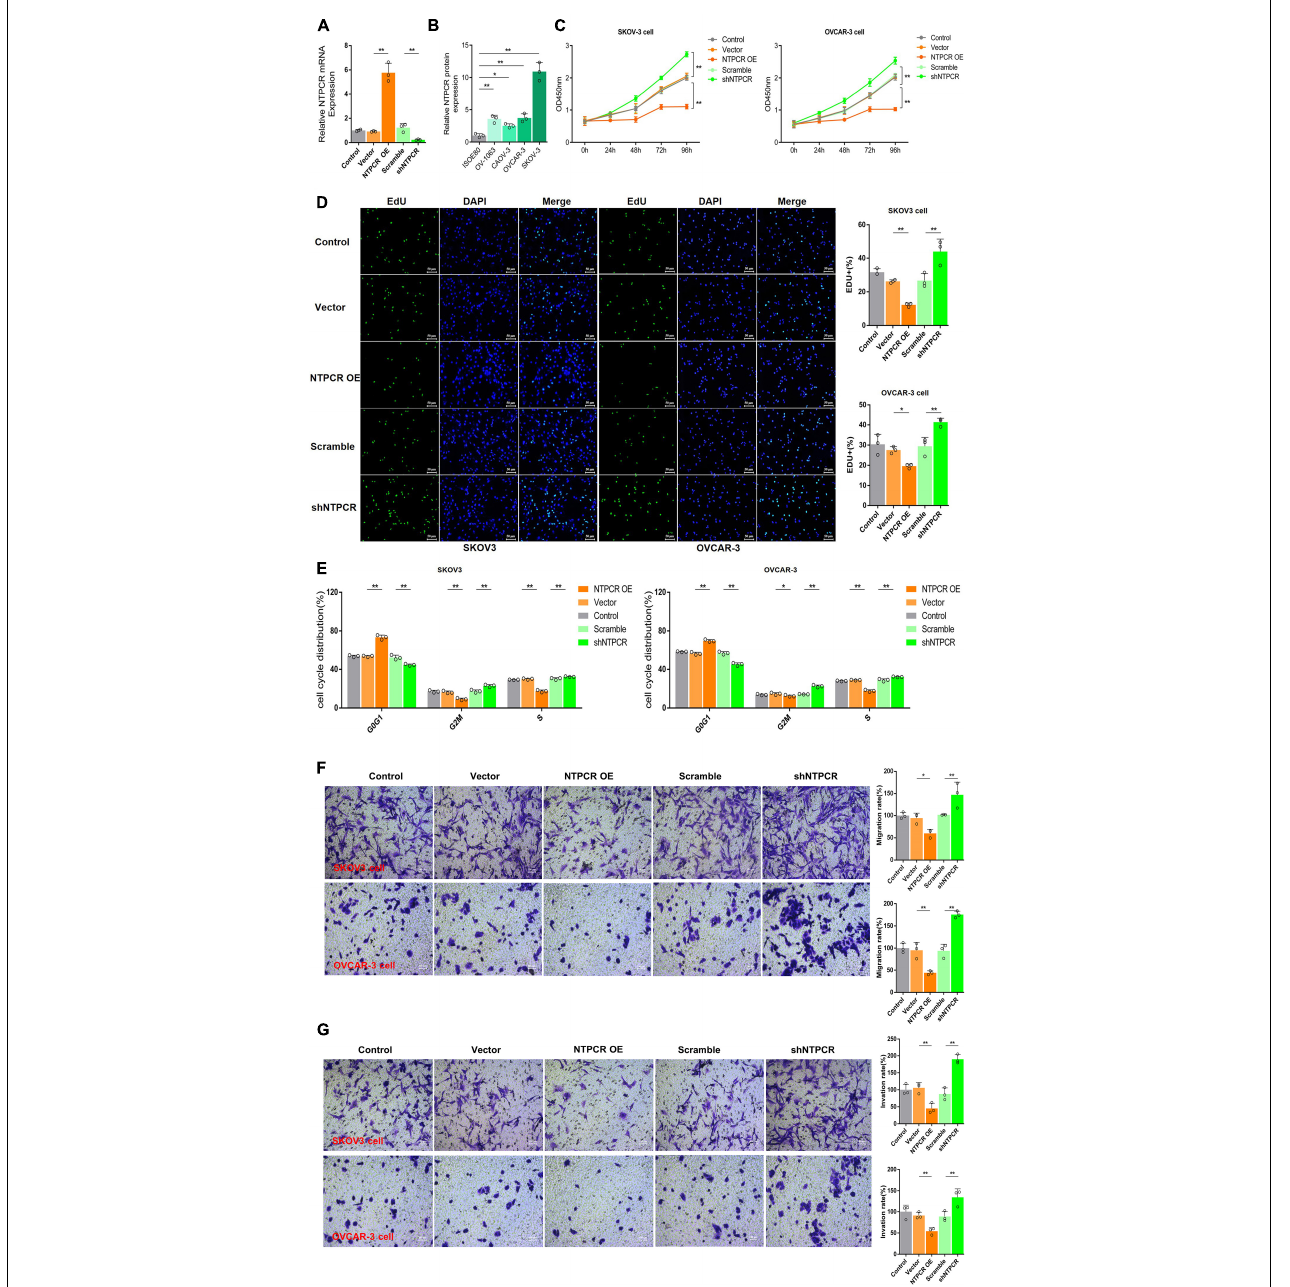
FIGURE 2 | Knocking out of NTPCR-induced cell proliferation, S phase arrest, promoted cell invasion, and migration in SKOV3 cell line. (A) The construction of the overexpression vector and interference shRNA vector of NTPCR. It can be seen from the left figure that compared with Scramble groups, the expression of NTPCR in shRNA groups was significantly reduced, and shRNA1 was more obvious. That is why we previously chose shRNA1 for the subsequent experimental studies. It also can be seen from the right figure that compared with the vector groups, the expression of NTPCR in NTPCR OE groups was significantly increased, and compared to the Scramble groups, shNTPCR groups were significantly reduced (* p < 0.05, ** p < 0.01). (B) NTPCR expression levels were significantly upregulated in four ovarian cancer cell lines (SKOV3 vs. IOSE80, p < 0.01; CAOV-3 vs. IOSE80, p < 0.05; OV-1063 vs. IOSE80, p < 0.01; and OVCAR-3 vs. IOSE80, p < 0.01) compared with the human ovarian epithelium cell line IOSE80. (C) The effect of NTPCR on the viability of epithelial ovarian cancer cells. The CCK-8 assays were performed to evaluate the cell proliferation after being cultured at 24, 48, 72, and 96 h (** p < 0.01). (D) The effect of NTPCR on the DNA replication ability of epithelial ovarian cancer cell lines SKOV3 and OVCAR-3. In the figure, EdU detects the DNA replication ability (* p < 0.05, ** p < 0.01). (E) The picture shows the distribution of the cell cycle detected by PI. NTPCR increased the proportion of G0/G1-phase cells in epithelial ovarian cancer cells and decreased the proportion of S-phase and G2/M-phase cells (* p < 0.05, ** p < 0.01). (F,G) Transwell assesses the effect of NTPCR on the migration and invasion of epithelial ovarian cancer cells. In SKOV3 cells and OVCAR-3 cells, overexpression of NTPCR reduced cell migration ability, and downregulation of NTPCR increased cell migration ability. The results show the same in the cell invasion experiment (* p < 0.05, ** p <